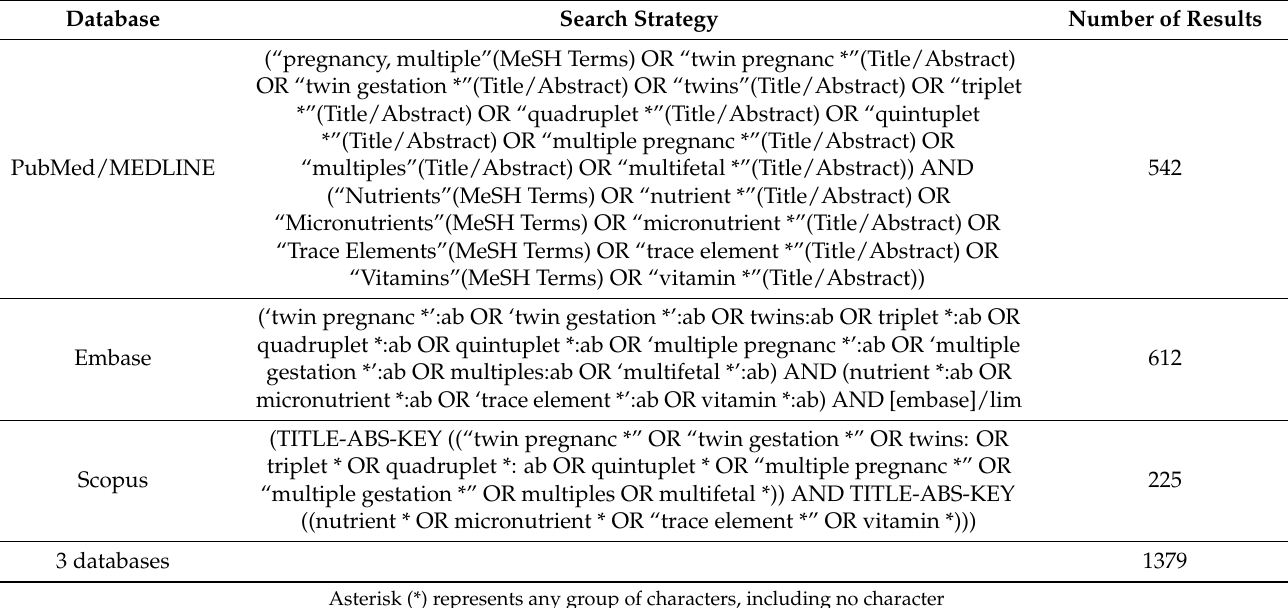
Table 1. Databases and the search strategy.